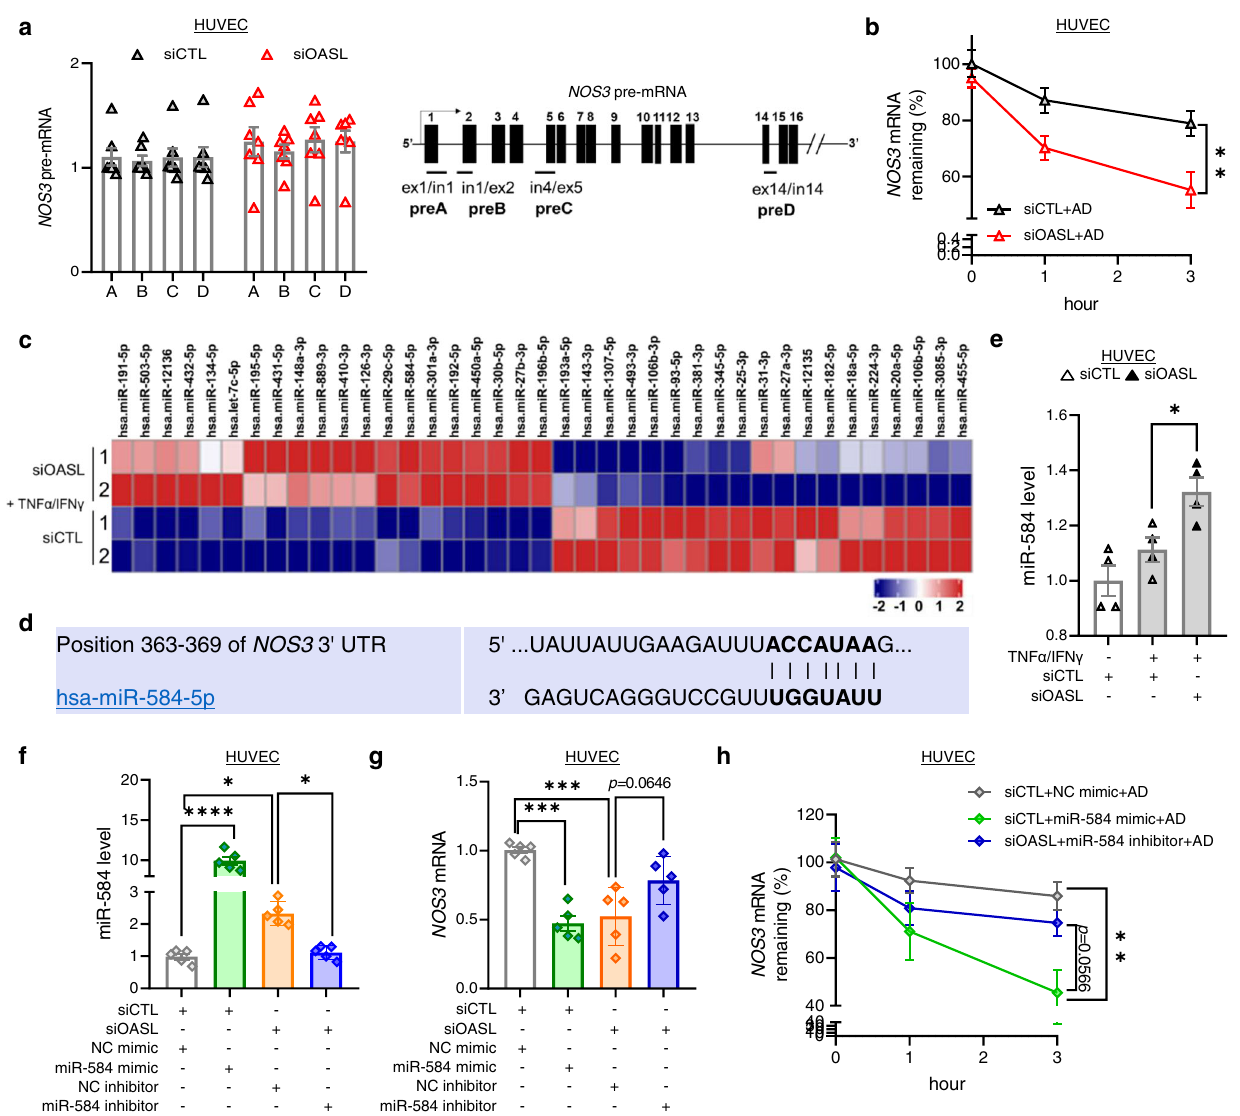
Fig. 7 | Endothelial OASL contributes to NOS3 mRNA stability by regulating NOS3 -targeting miRNAs.a NOS3 pre-mRNAlevelsmeasuredbydetecting primary transcripts isolated from siCTL- or siOASL-transfected HUVECs ( n =7 per group). b qRT-PCR – based analysis of NOS3 mRNA stability in siCTL- or siOASL-transfected HUVECs(3h: p =0.0035, n =7forsiCTL+AD; n =8forsiOASL+AD). NOS3 mRNAwas measured over time in the presence of actinomycin D (AD), which was added to block transcription. c microRNA (miRNA)-seq analysis performed on HUVECs transfected with siCTL or siOASL and stimulated with TNF- α and IFN- γ ( n =2 per group), depicted as a heatmap showing differences in miRNA expression patterns between the two groups. d The miR-584-5p binding site within the NOS3 3 ʹ -UTR region as predicted by TargetScan. e qRT-PCR analysis of miR-584 expression in